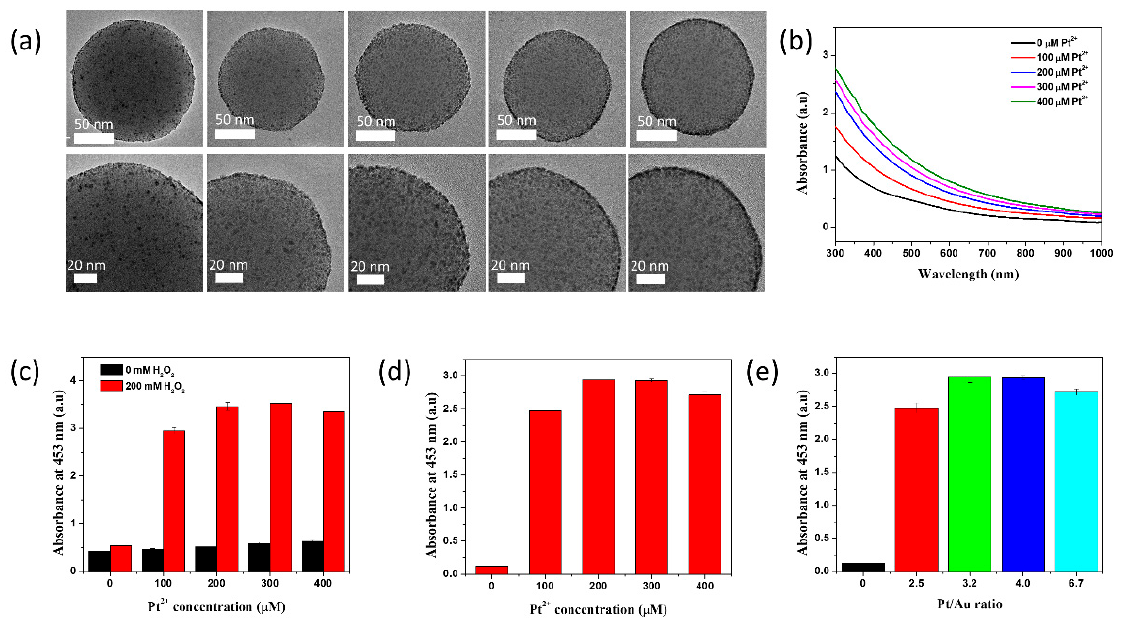
Figure 3. ( a ) TEM images are shown at different magnifications. ( b ) UV–Vis absorbance spectroscopy images of SiO 2 @Au@Pt NPs fabricated with various concentrations of Pt 2+ . ( c , d ) Absorbance plots of SiO 2 @Au@Pt NPs and ( e ) Effect of Pt/Au ratio on the absorbance at 453 nm in the presence of TMB and H 2 O 2 fabricated with various concentrations of Pt 2+.